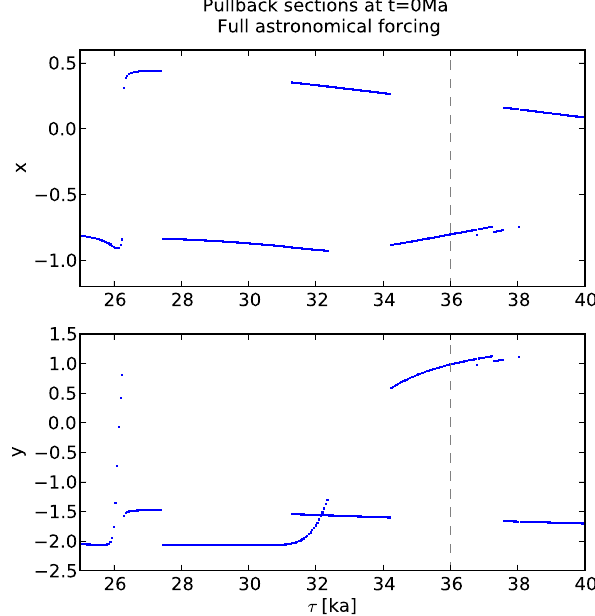
Fig. 14. As Fig. 9 but with the full astronomical forcing, with pa- rameters as in Fig. 13 and γ = 1 .